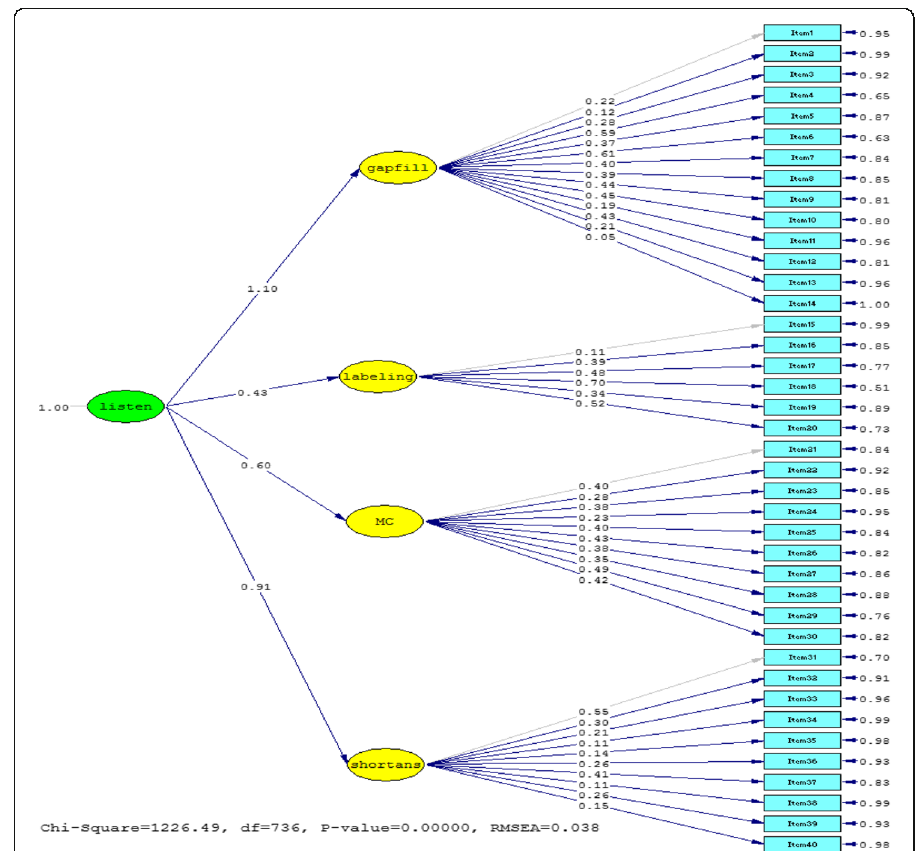
Fig. 1 Model for factor structure of IELTS